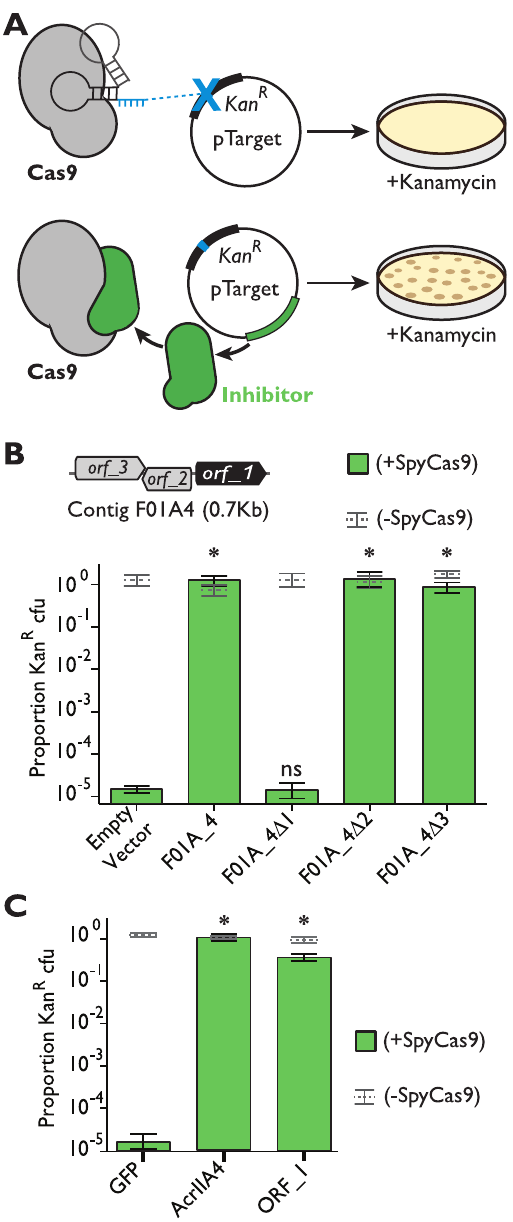
Fig 1. Functional selection reveals a metagenomic contig encoding a novel SpyCas9 inhibitor. ( A ) A plasmid protection assay was used to reveal SpyCas9 inhibition. In this assay, plasmids without SpyCas9 inhibitors are cleaved by Cas9 and do not give rise to Kan R colonies, whereas those encoding inhibitors withstand SpyCas9 attack and yield Kan R colonies. ( B ) The contig F01A_4 protects a plasmid from SpyCas9 attack, but an early stop codon in orf_1 ( Δ 1) eliminates this phenotype. Stop codons in orf_2 or orf_3 ( Δ 2 and Δ 3 ) have no effect. Thus, we conclude that orf_1 is necessary for inhibition of SpyCas9. Asterisks depict statistically significant differences in plasmid retention between the indicated genotype and an empty vector control in SpyCas9-inducing conditions (Student t test, p < 0.002, n = 3); ns indicates no significance. All p -values were corrected for multiple hypotheses using Bonferroni method. ( C ) Expression of orf_1 (which we name acrIIA22 ) is sufficient for SpyCas9 antagonism, protecting a plasmid as effectively as acrIIA4 . Asterisks are as in panel B but relate to the GFP negative control rather than to an empty vector. The individual numerical values that underlie the summary data in this figure may be found in S1 Data. Kan R , kanamycin resistance; SpyCas9, Streptococcus pyogenes Cas9.